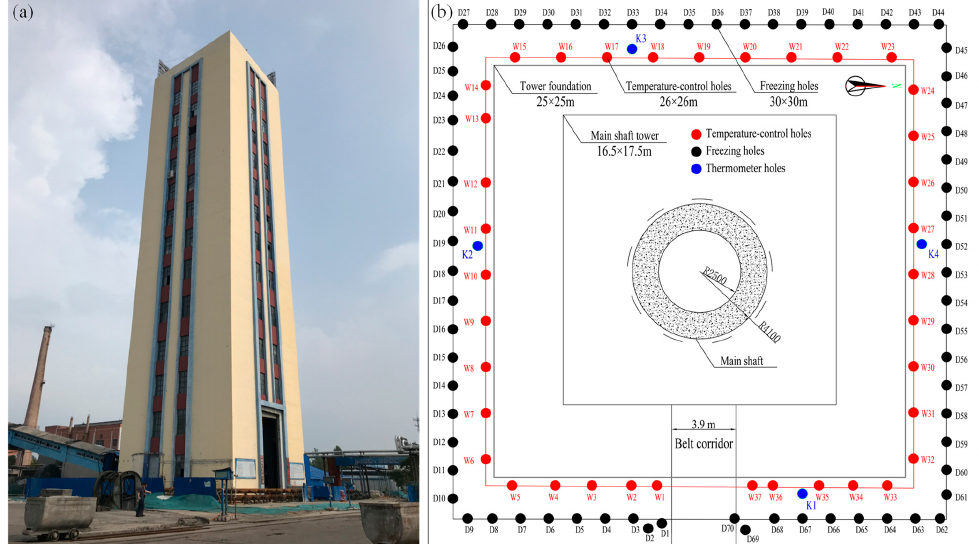
Figure 1. The main shaft tower ( a ) and layout of boreholes ( b ) in Chensilou Coal Mine.